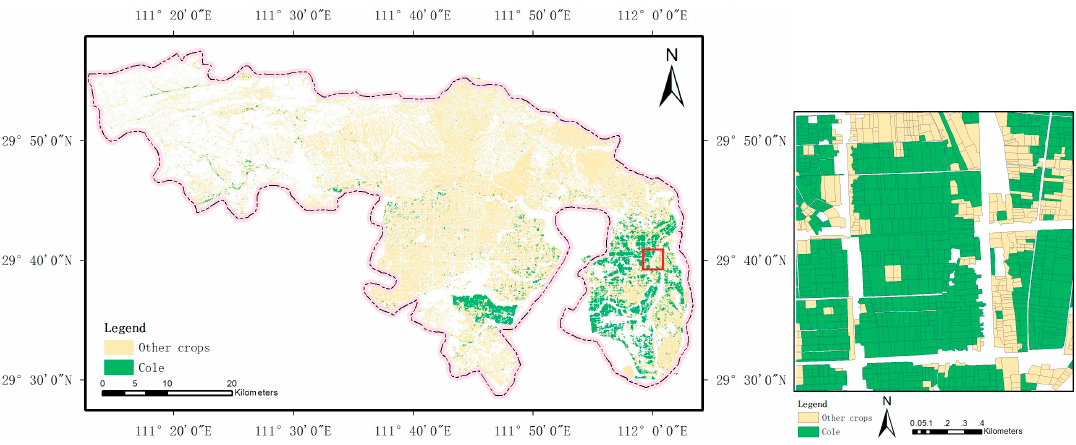
Figure 13. Map of cole.